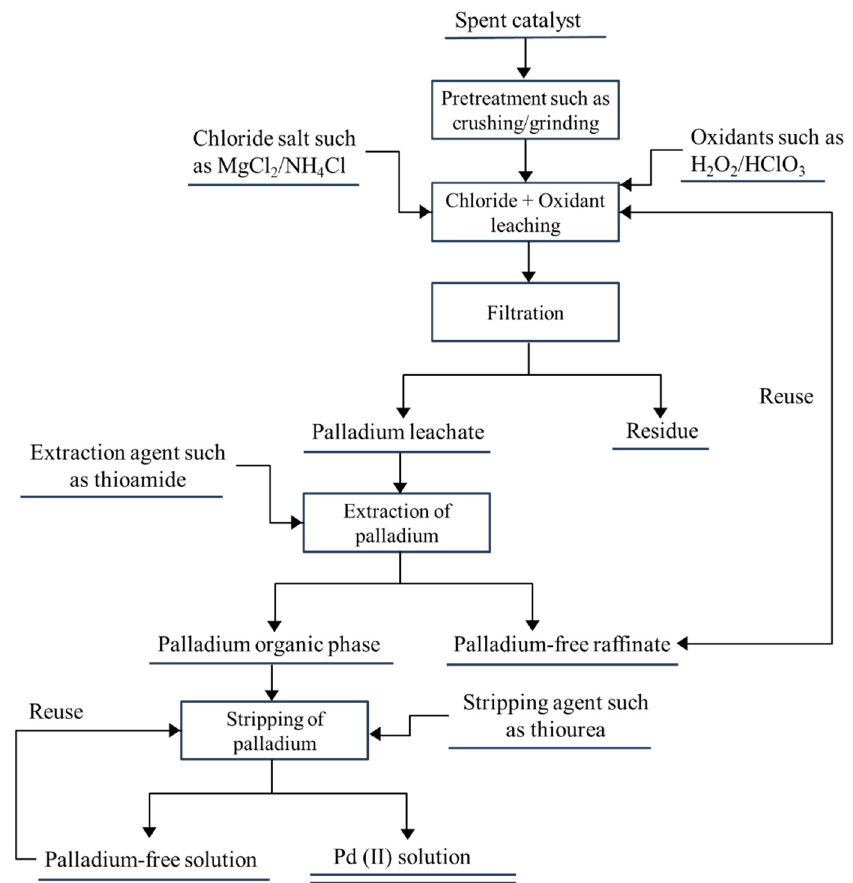
Figure 3. The flowchart of chloride leaching combined with solvent extraction.